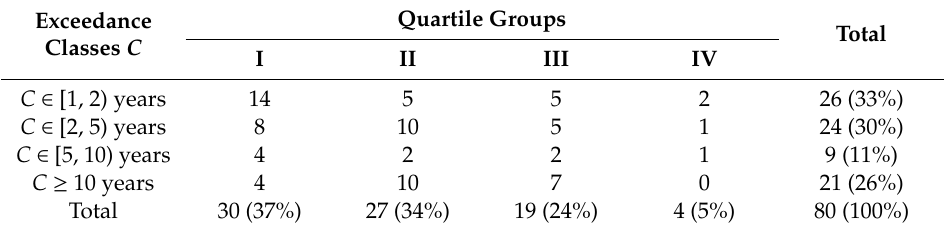
Table 2. Number of precipitations by exceedance frequency classes in Hu ff ’s quartile